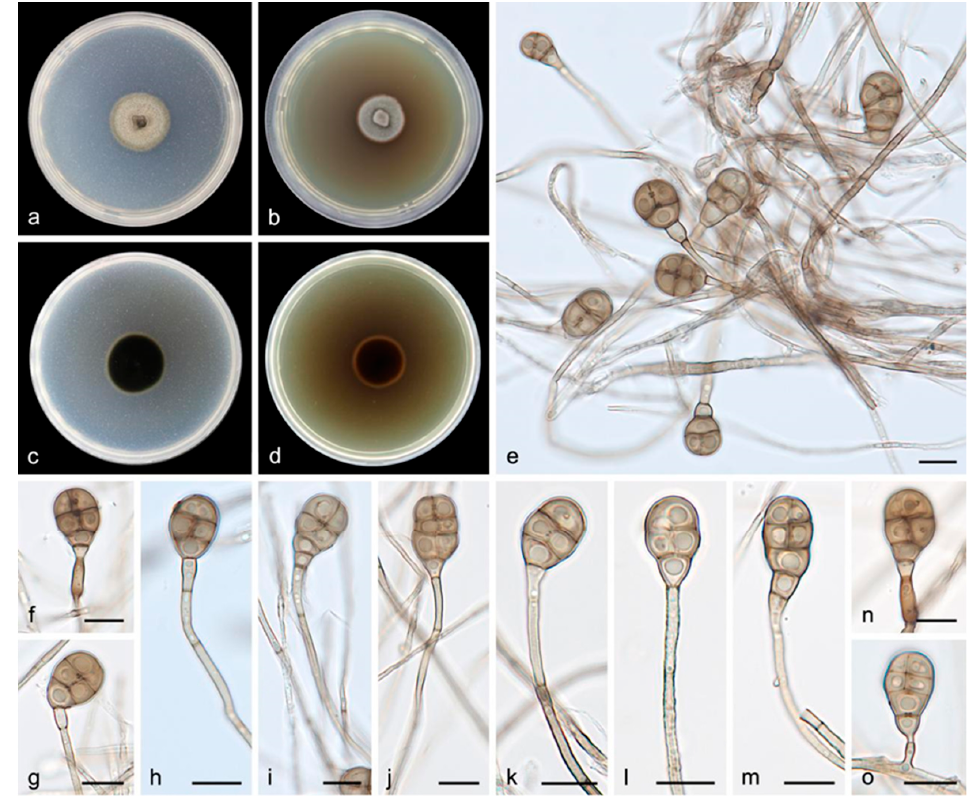
Figure 5. Acrodictys pigmentosa (holotype HMAS 352239, ex ‐ holotype SAUCC 1591): ( a , b ) surface sides of colony after incubation for 7 days on PDA ( a ) and MEA ( b ); ( c , d ) reverse sides of colony after incubation for 7 days on PDA ( c ) and MEA ( d ); ( e – o ) conidiophores, conidiogenous cells, and conidia. Petri dish diameter: 90 mm ( a – d ). Scale bars: 10 μ m ( e – o ). Etymology ― The epithet pigmentosa originates from its pigmented colony on MEA.